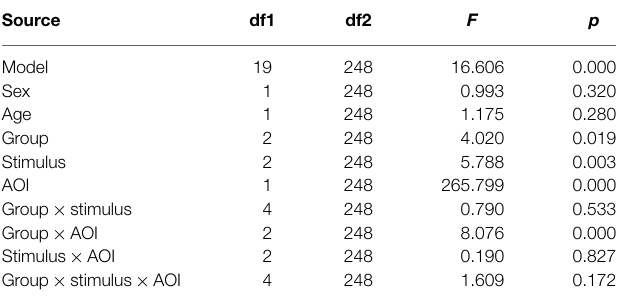
TABLE 3 | Means, SDs, and confidence intervals of total fixation time as a function of type of stimulus . Type of stimulus